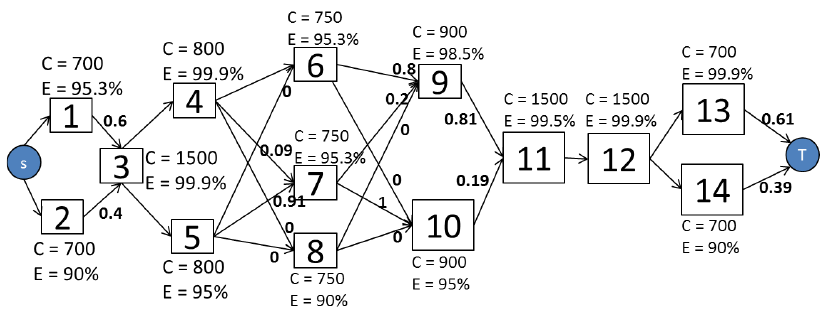
Figure 6. EFM model after PLDA execution.